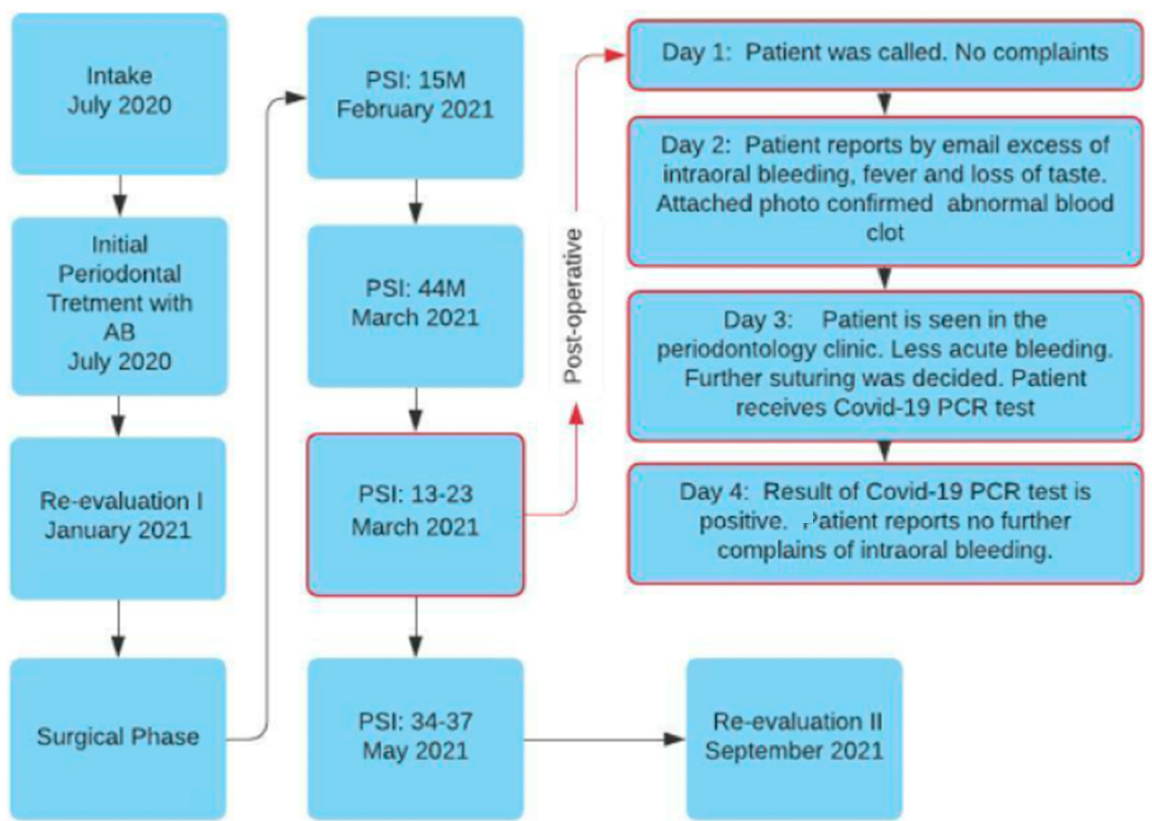
Figure 1. Treatment modalities from intake to the end of active periodontal treatment at 6-month post-operative. Abbreviations: AB = adjunctive use of antibiotics (amoxicillin, 375 mg, and metronidazole, 500 mg) three times a day for 7 days starting 1 day prior to the intervention, PSI = periodontal surgical intervention with involved tooth number(s), M = mesial.